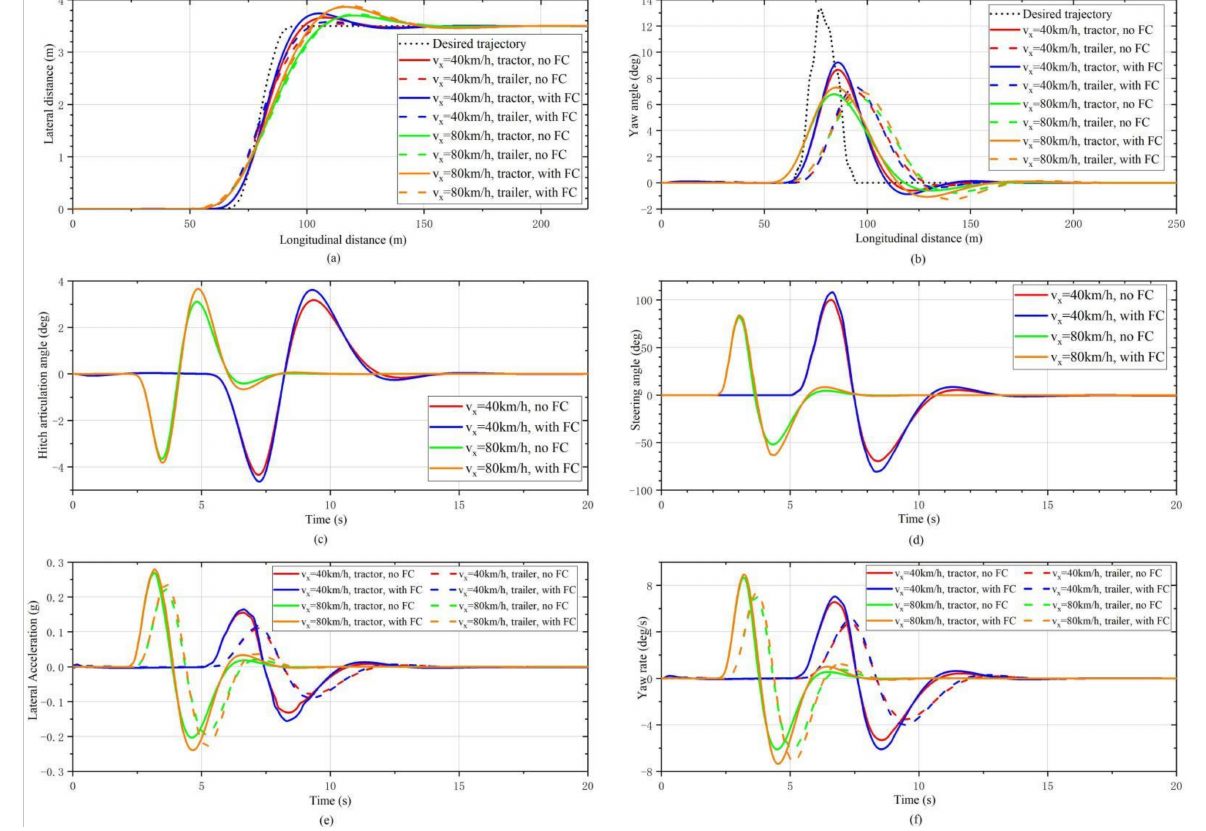
Figure 10. Simulation results of AAAP-PFA with and without FC. ( a ) Trajectory. ( b ) Yaw angle. ( c ) Hitch articulation angle. ( d ) Steering angle. ( e ) Lateral acceleration. ( f ) Yaw